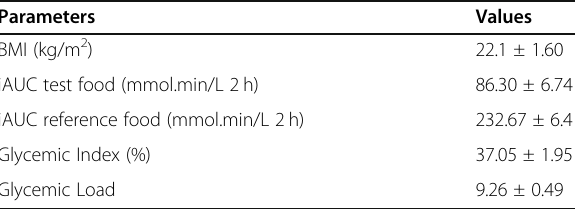
Table 3 Characteristics of participants ( n = 10) enrolled and glycemic responses reported in glycemic index (GI) study Parameters